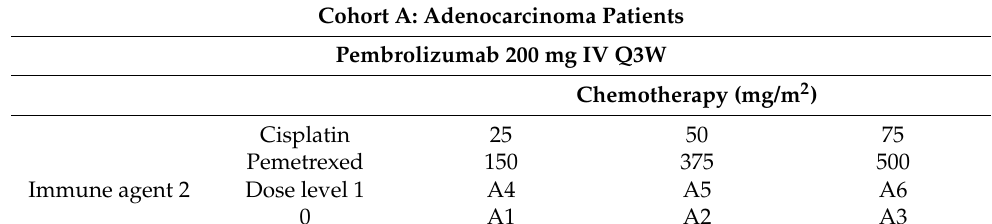
Table 1. Treatment combinations by